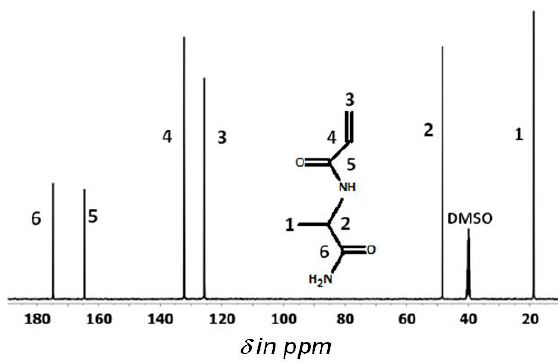
Figure 3. The 13 C-NMR (400 MHz proton) spectrum of NA L ALA in d6-DMSO.